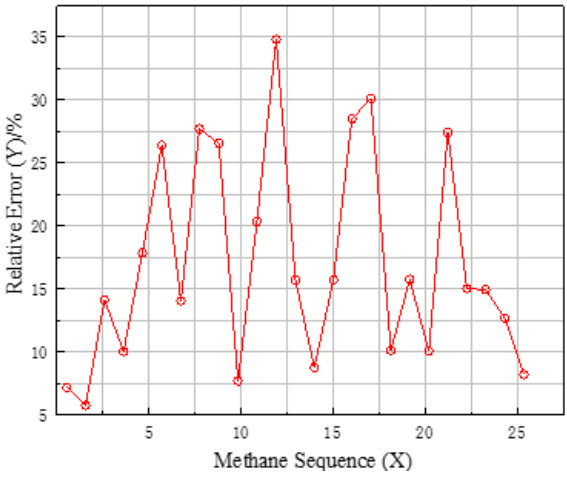
Figure 6. RBF neural network model relative error.